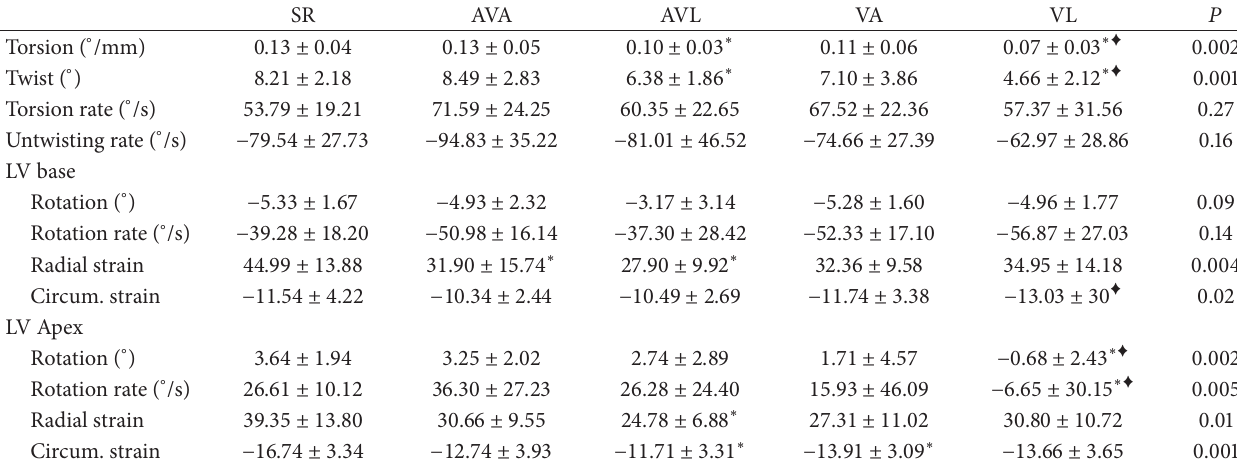
Table 2: Comparison between left ventricular torsional and strain parameters during sinus rhythm and in relation to various pacing modes and sites.